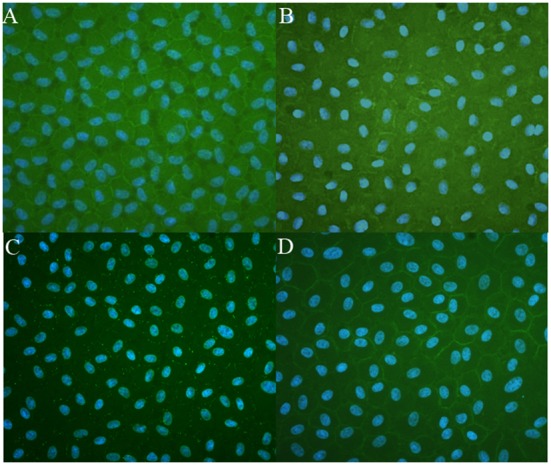
Photomicrographs of immunostaining showing expression of the membrane markers ZO-1 A), Na+K+/ATPase (B), connexin 43 (C), and N-cadherin (D) immunostaining of a confluent layer of corneal endothelial cells (CECs) isolated and expanded in DMEM + F12 medium supplemented with 10% heat-treated platelet releasate (HPR).(Cell nuclear markers were stained with DAPI. Proteins were clearly localized at plasma membranes of cells with a hexagonal shape (magnification 200x).